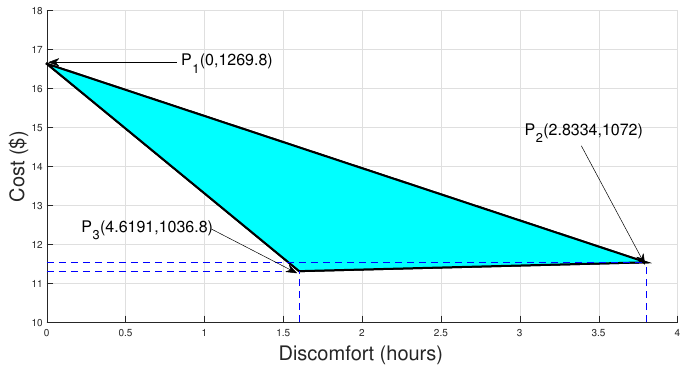
Figure 13. Feasible region.